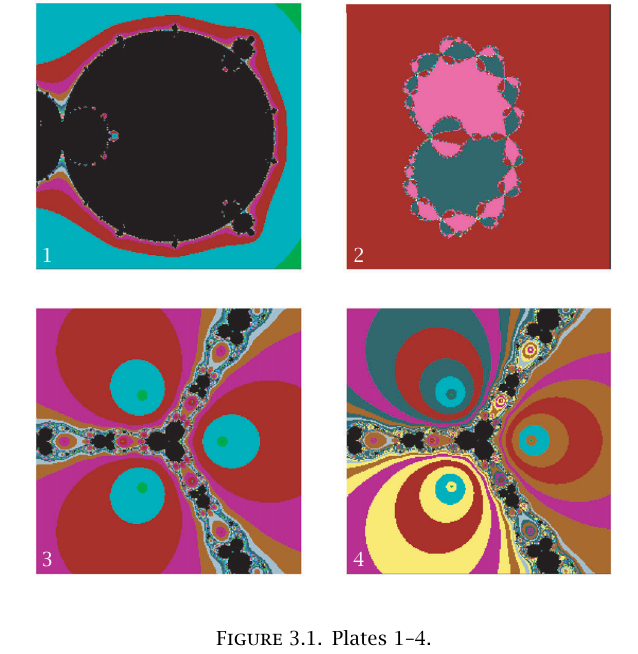
Figure 3.1 . Plates